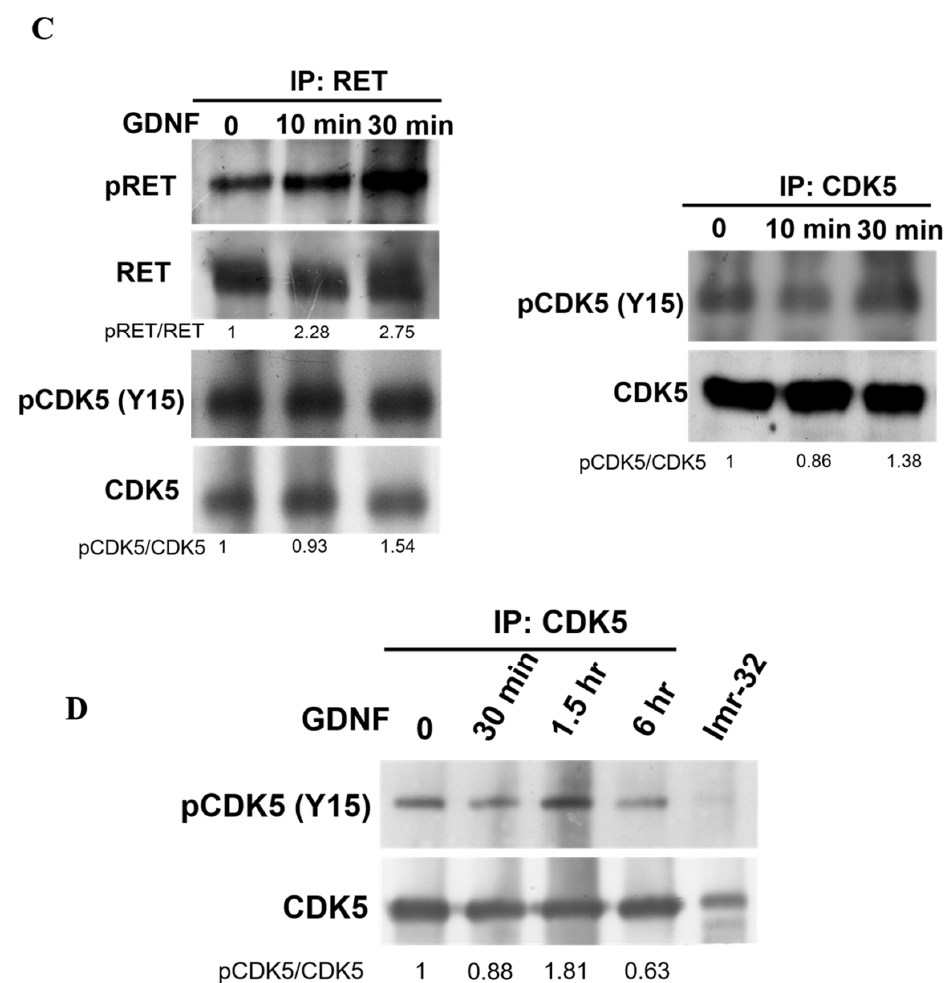
Figure 2. CDK5 biochemically interacts with RET protein. ( A ) Western blot data from co-immunoprecipitated RET and CDK5 protein, respectively. RET, CDK5 proteins were detected. ( B ) Immunocytochemistry data representing intracellular localization of CDK5 (green) and RET (red) proteins with the absence and presence of GDNF. Blue color indicates nucleus staining with DAPI. The yellow color in the merged image indicates the colocalization of two proteins. ( C ) Western blot data from co-immunoprecipitated RET and protein expression levels of pRET, total RET, pCDK5 and total CDK5 under GDNF treatment for 10 and 30 min, respectively. Western blot data from co-immunoprecipitated CDK5 and the protein expression level of pCDK5 and total CDK5 with GDNF treatment for 30 min, 1.5 h and 6 h, respectively. ( D ) Western blot data from immunoprecipitated CDK5 and immunoblotting CDK5 and pCDK5 (Y15) under time-dependent GDNF treatment. Imr-32 (human neuroblastoma cell line) serves as a positive control for CDK5 and p35 protein, since their expression are higher in Imr-32 cells.